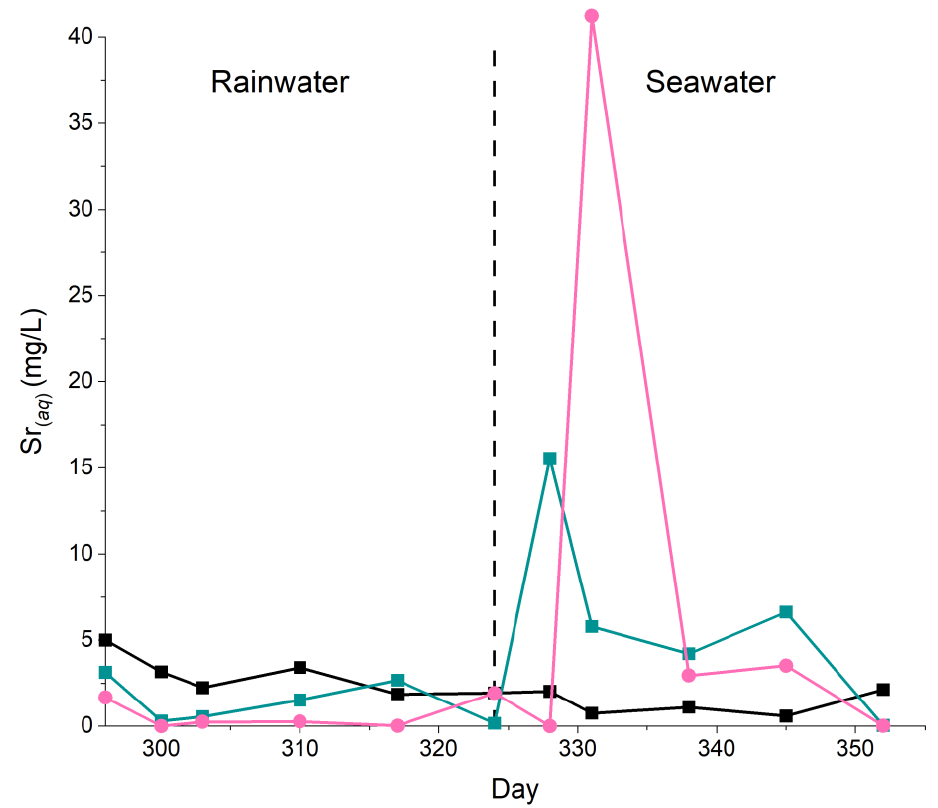
Figure 5. Concentration of Sr (aq) in effluent for three column systems over 56 days of remobilisation experiments: ( black ) rock flour, ( green ) rock flour + bentonite (6 wt.%), and ( pink ) rock flour + bentonite (6 wt.%) + steel coupons, after centrifugation at 1.4 × 10 4 × g for 5 mins. The dashed line signifies the change from rainwater (left) to seawater (right) input.